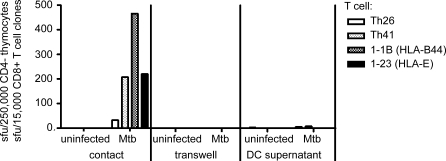
Mtb-Reactive Thymocytes Require Cell Contact with Mtb-Infected DC to Produce IFN-γCD4-depleted thymocytes (250,000 cells/well) were tested for their ability to produce IFN-γ in an ELISPOT assay in response to uninfected or Mtb-infected DC (50,000 cells/well) that were either placed directly in contact with the T cells (contact) on the ELISPOT membrane or placed in the upper wells of a 96-well Transwell plate (0.4-μm pore size) above the ELISPOT plate (transwell). Supernatants (100 μl) from uninfected or Mtb-infected DC were added directly to the T cells (supernatant). CD8+ T cell clones (15,000 cells/well) were used as positive controls for the response to Mtb-infected DC. Comparable results were obtained in 3 separate experiments.